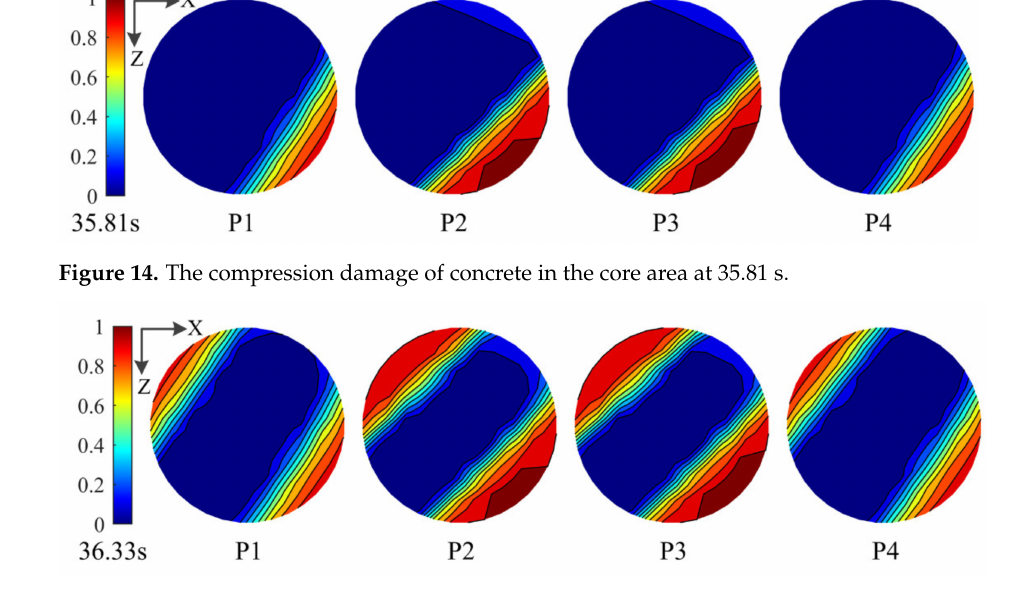
Figure 15. The compression damage of concrete in the core area at 36.33 s.